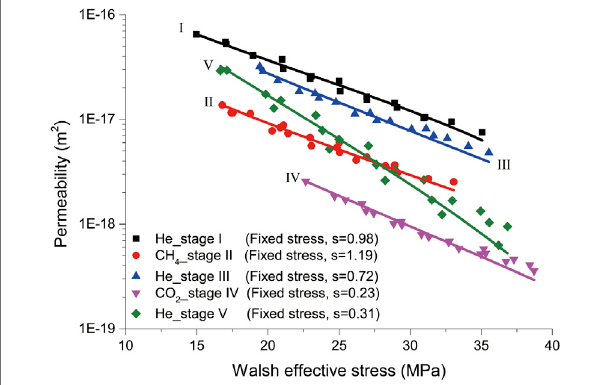
FIGURE 7 | Permeability measured at all stages performed under the fi xed stress boundary condition, plotted in logarithms, as a function of the Walsheffective stress.Note that s istheWalsh effective stresscoef fi cient,and thelinesrepresentthebest fi ttingsof Eq.2 tothedatapoints.Thevalues of σ e 0 and κ 0 usedforeachstageandtheparametervaluesobtainedarelisted in Table 2 .